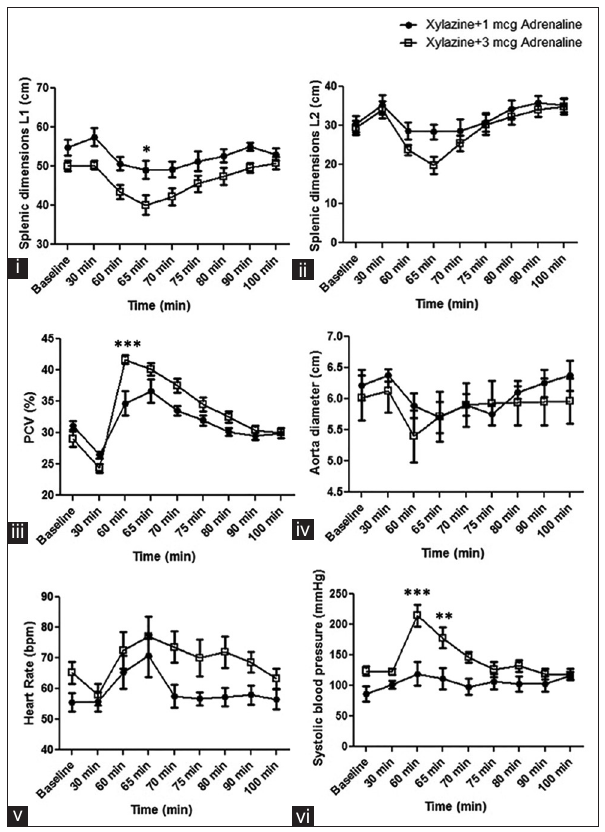
Figure-4: Two-way analysis of variance revealed an interaction of xylazine (0.5 mg/kg IV) and differences dose of adrenaline (1 mcg and 3 mcg IV) on (i) splenic dimensions; L1=Dorsocaudal to ventrocranial splenic edges; (ii) L2=Dorsocaudal to ventrocaudal splenic edges; (iii) pack cell volume; (iv) aorta diameter; (v) heart rate; (vi) systolic blood pressure; before drug administration (baseline), 30 min (T30), 60 min (T60), 65 min (T65), 70 min (T70), 75 min (T75), 80 min (T80), 90 min (T90), and 100 min (T100) after drug administration, *p<0.05, **p<0.01, ***p<0.001 versus the